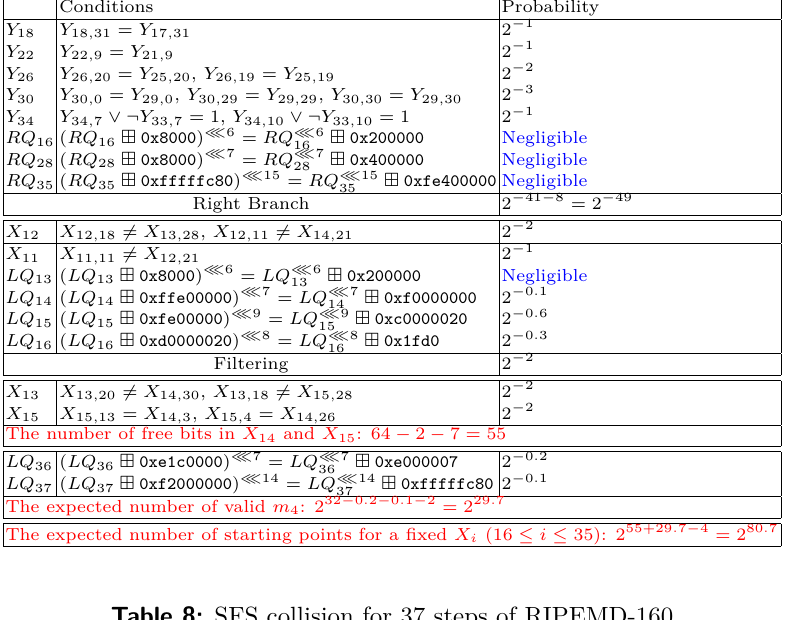
Table 8: SFS collision for 37 steps of